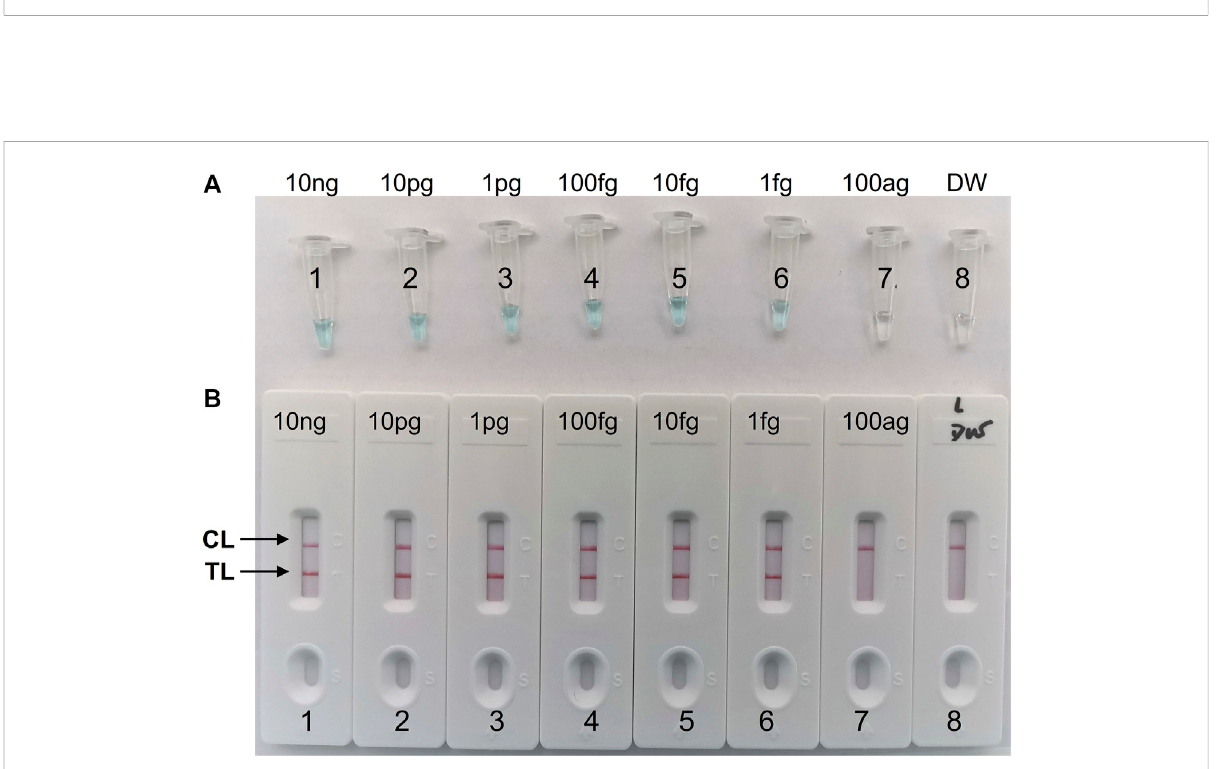
FIGURE 4 Sensitivity analysis ofthe C . albicans -LAMP-LFBassaywithserial dilutions of C . albicans genomicDNAconcentrations. Twodetection methods involving a colorimetric indictor (VDR) (A) and LFB (B) were used to analyze the LAMP products. The genomic DNA was serially diluted (10 ng, 10 pg, 1 pg, 100 fg, 10 fg, 1 fg, and 100 ag per microliter) and subjected to standard LAMP. Tubes A1-7 (Biosensors B1-7), C . albicans strain (ATCC 10231) genomic templates (10 ng-100 ag); Tube A8 (Biosensor B8), blank control (DW), respectively. The LoD of C. albicans -LAMP was one fg per